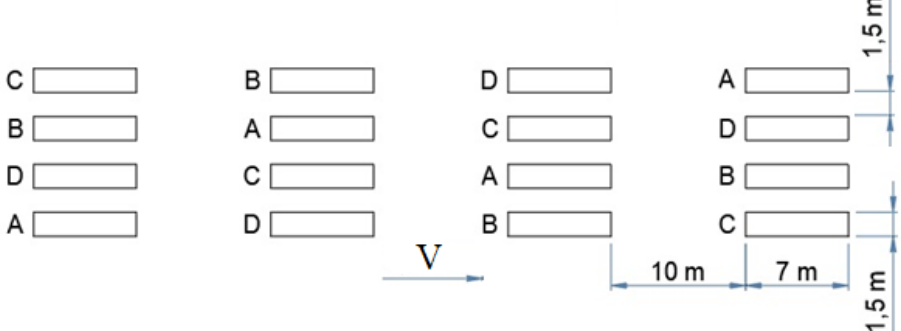
Figure 1. A diagram of the placement of experimental plots in onion cultivation, including plot size and insulation strips (source: own